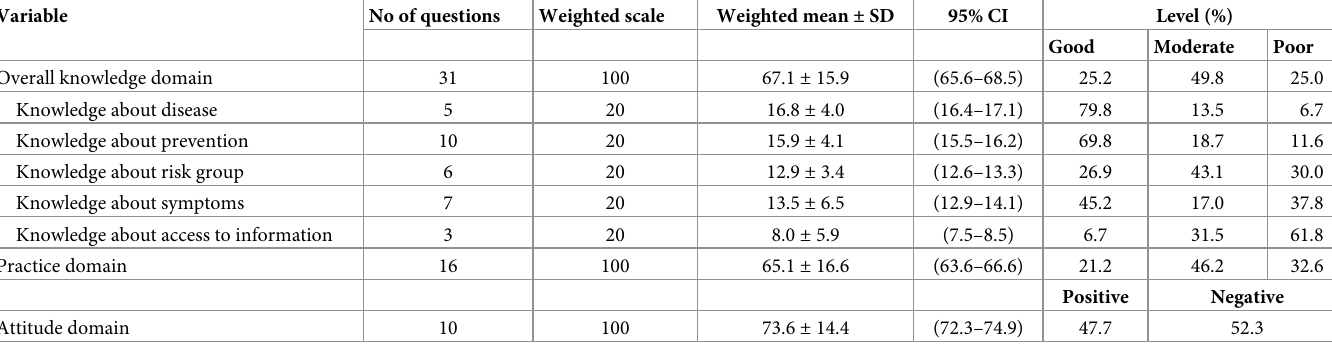
Table 3. Average level of knowledge, attitude, and practice towards COVID-19 among the respondents.